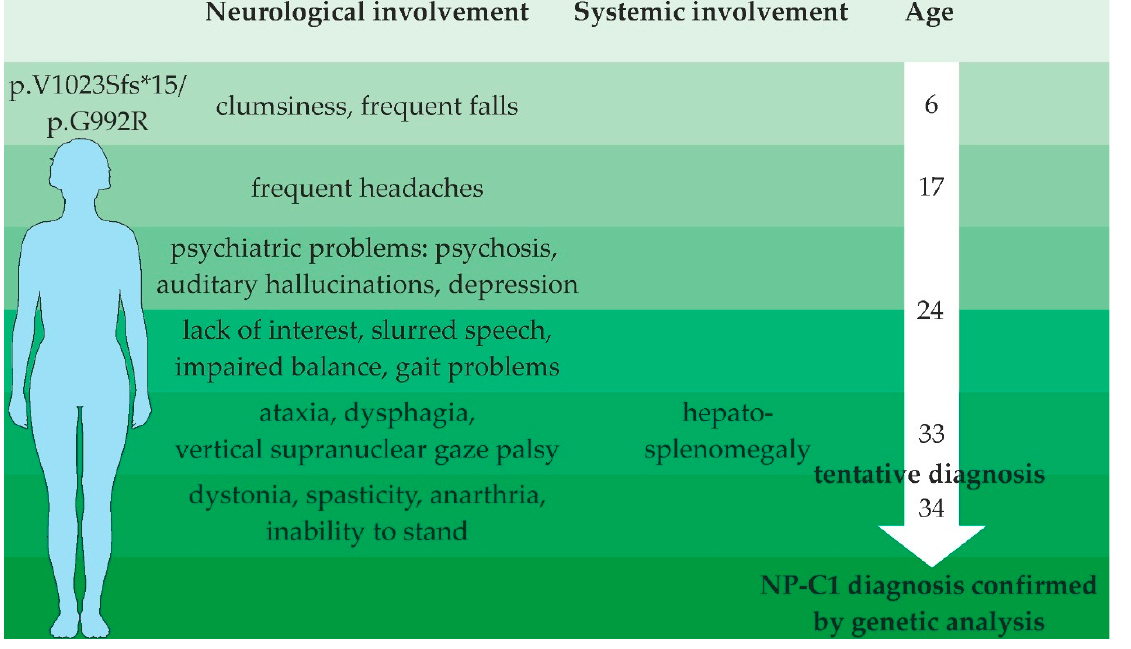
Figure 7. Schematic overview of the patient’s disease course.